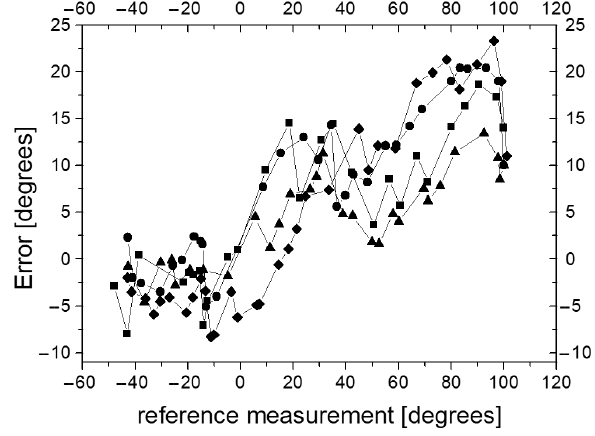
Figure 16. Angular differences (error) between D3 and reference frame readings. The different symbols correspond to four series of measurements.